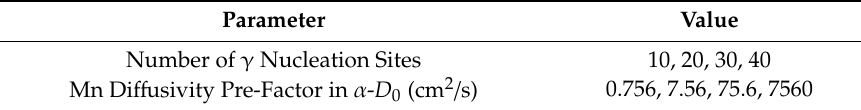
Table 2. Parameter Variations for MICRESS ® Simulations.